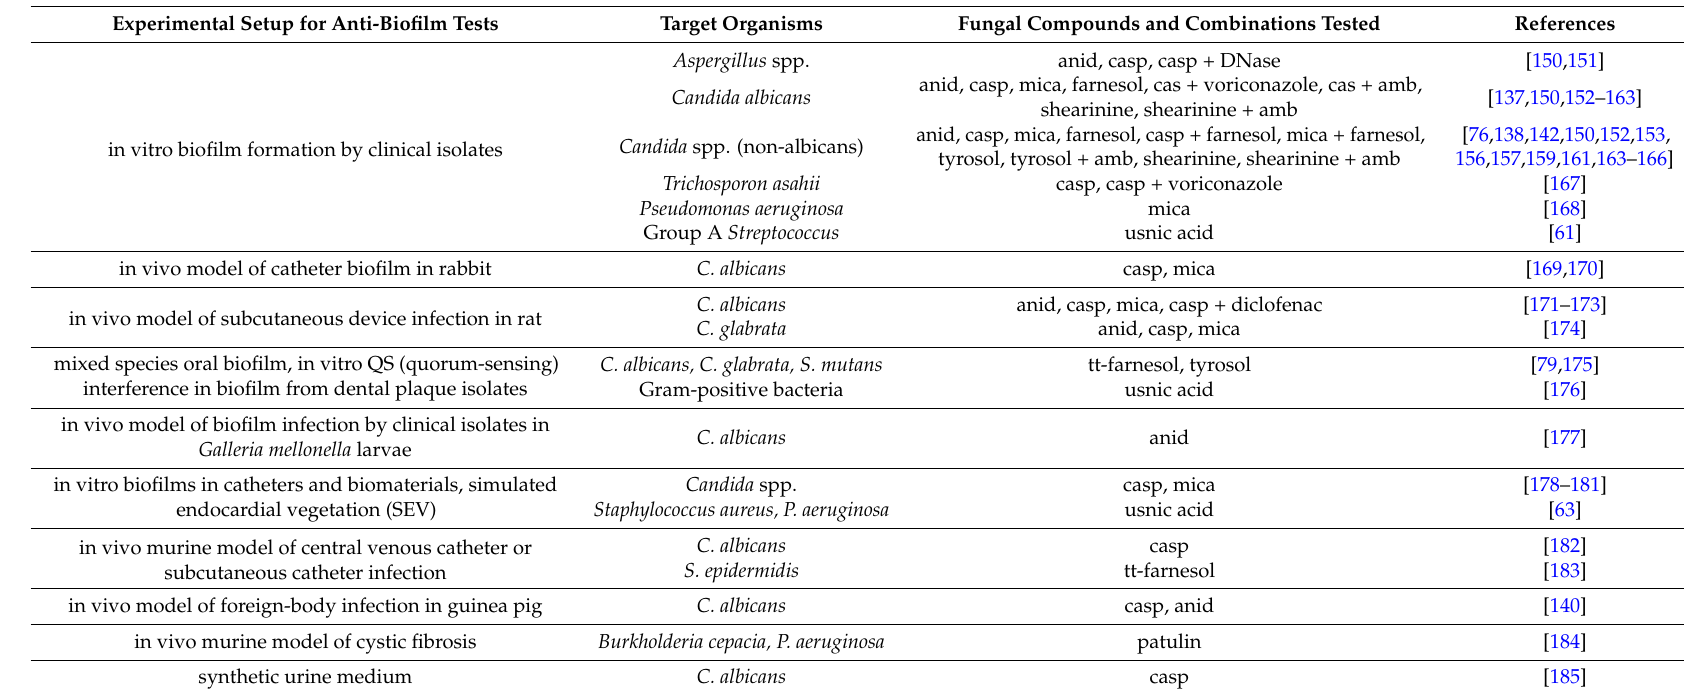
Table 1. Examples of preclinical studies focusing on anti-biofilm properties of fungal